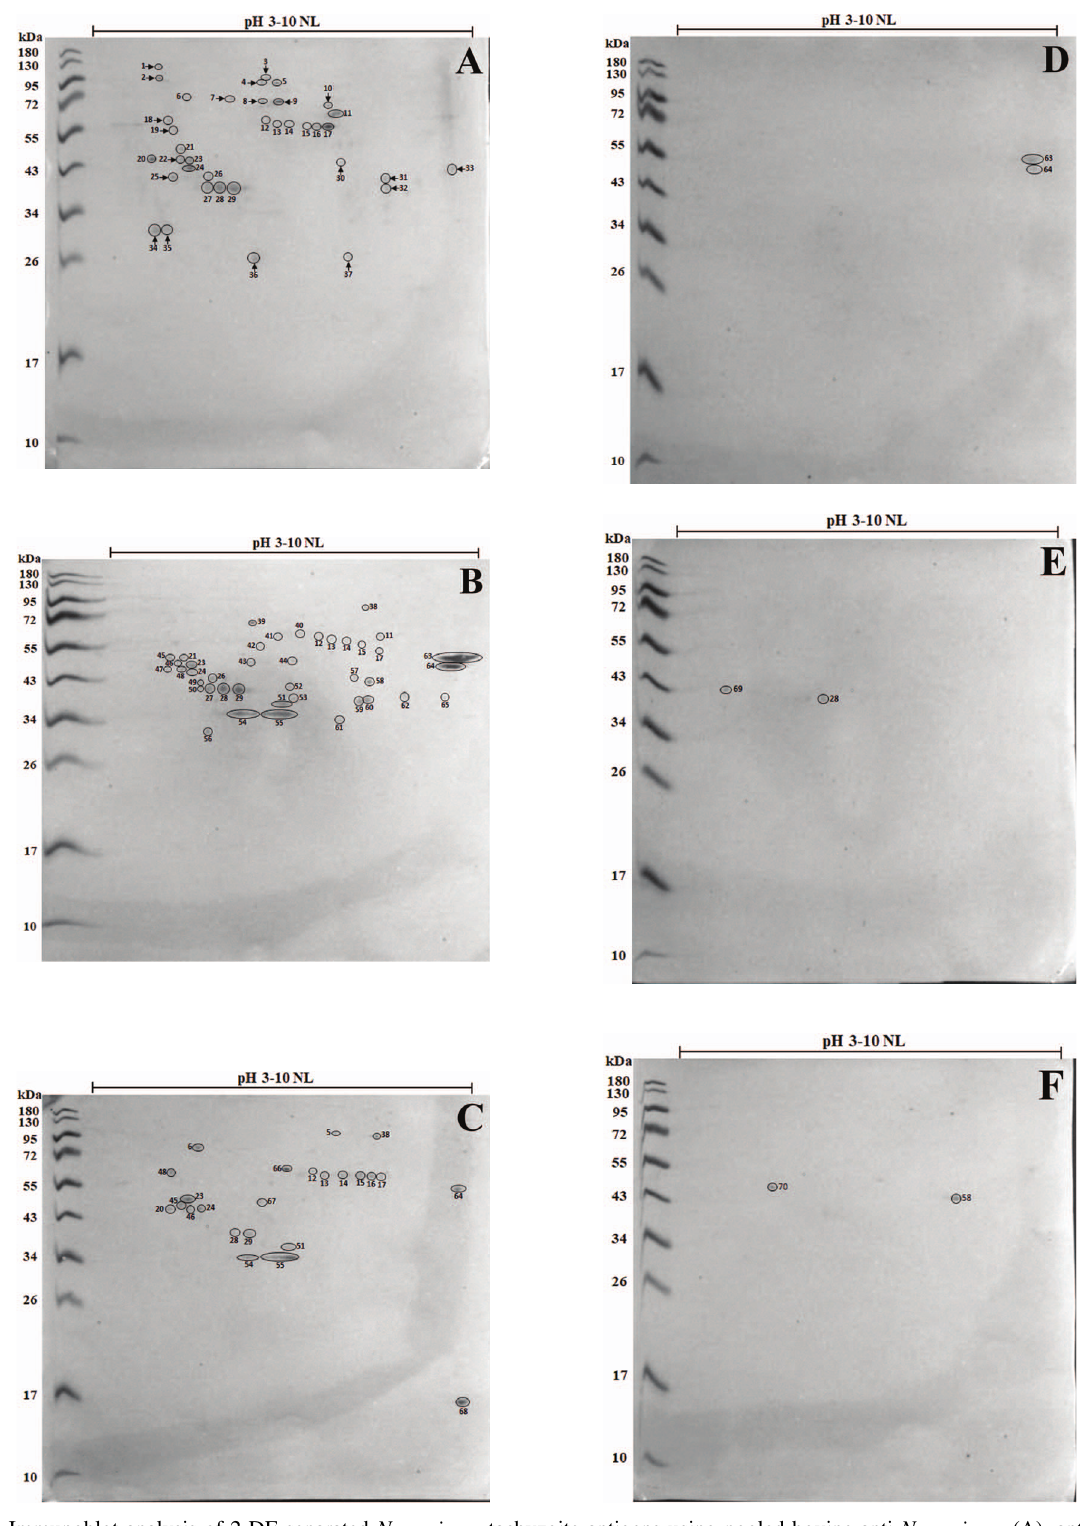
Figure 2. Immunoblot analysis of 2-DE-separated N. caninum tachyzoite antigens using pooled bovine anti- N. caninum (A), anti- T. gondii (B), anti- C. parvum (C), anti- B. bovis (D) and anti- B. bigemina (E) sera and healthy serum (F). The arrows indicate 20 protein spots corresponding to 14 different antigenic proteins recognised by N. caninum -positive sera, and those without arrows indicate spots cross-reactive with other apicomplexan protozoan-infected